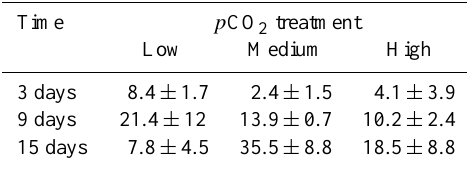
Table 5. Quantity of DIP (nmoll − 1 ) transformed to DOP by N. spumigena. Calculation was done using the proportion of [ 33 P]DOP to total [ 33 P] at each sampling day considering the initial DIP con- centration + DIP concentration added at day